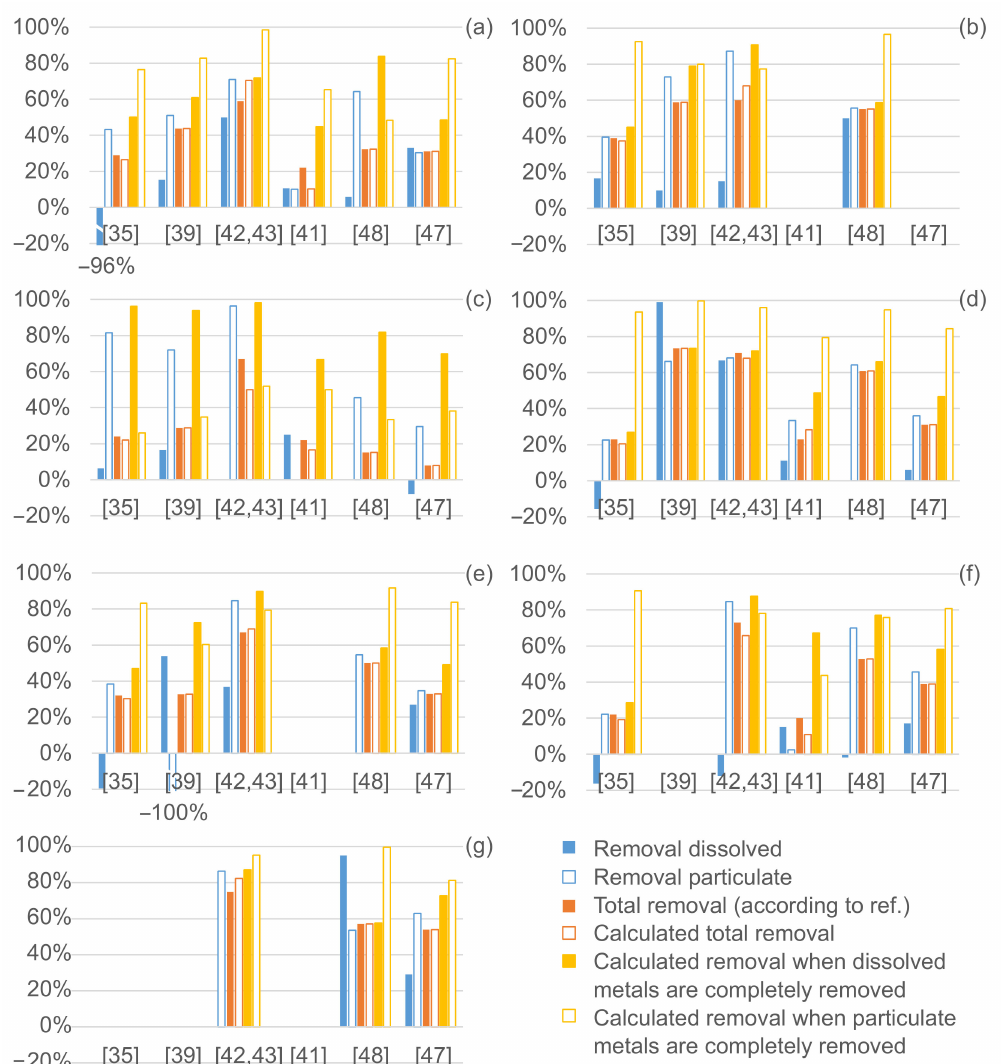
Figure 4. Current removal during primary settling (removal dissolved, particulate, according to reference and calculated removal) and potential for improved removal of dissolved (sorption) and particulate heavy metals (coagulation/flocculation) for: ( a ) Cu; ( b ) Cr; ( c ) Ni; ( d ) Pb; ( e ) Cd; ( f ) Zn; ( g ) Hg. (Data for As and Ag not available.) The removals according to the references (current dissolved and particulate removal) ([35,39,41–43,47,48]) are given compared to the calculated